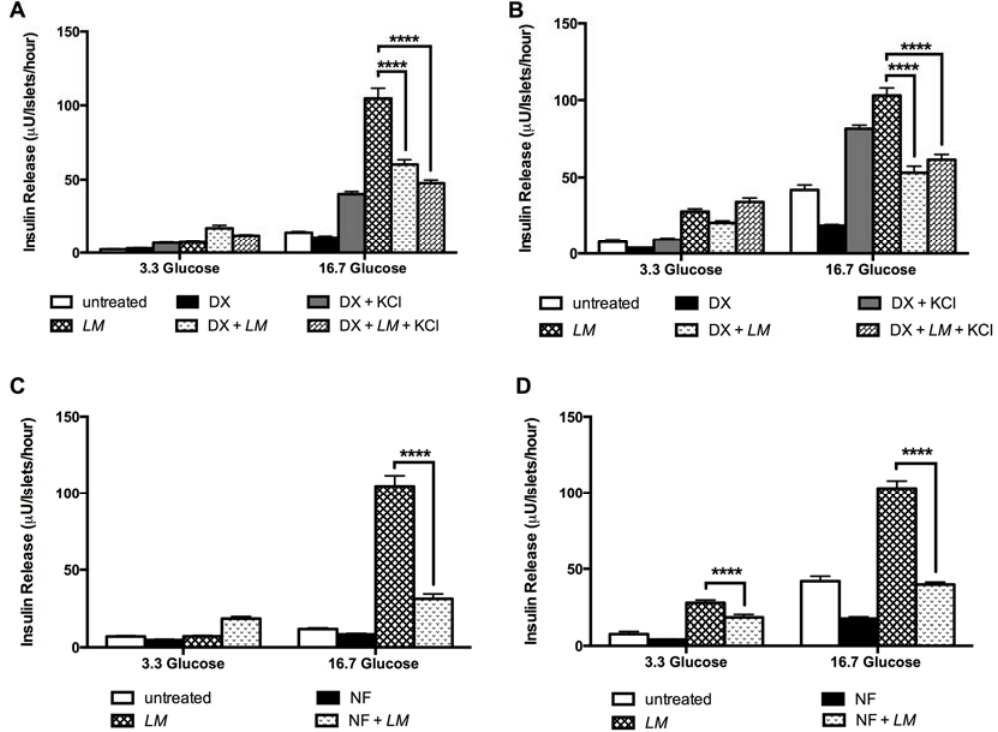
Figure 8. LM -dependent insulin release is mediated by ATP sensitive potassium channels and L-type calcium channels. LM effect was evaluated in islets cultured in low (3.3 mM) and high (16.7 mM) glucose in presence of DX (0.25 mM) and or KCl in GK ( A ) and W rats islets ( B ); NF (10uM) in GK ( C ) and W rats islets ( D ). Insulin concentration was measured by RIA. Data are presented as means ± standard error of the mean (SEM) ( n = 8). **** p < 0.0001 when compared to islets treated with LM alone.